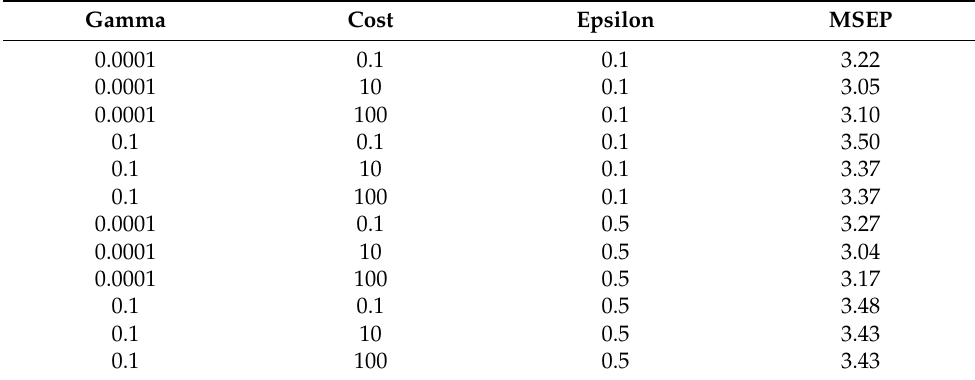
Table 1. Summary of results from SVR parameter estimation with RBF